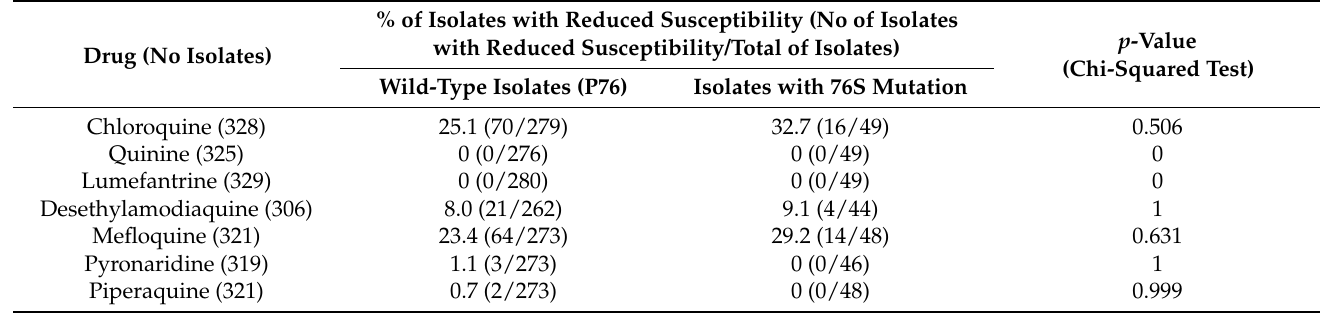
Table 4. Proportions of isolates with in vitro reduced susceptibility to chloroquine, quinine, lumefantrine, desethylamodi- aquine, pyronaridine, and piperaquine according to the pfcoronin genotype (P76 or 76S). % of Isolates with Reduced Susceptibility (No of Isolates with Reduced Susceptibility/Total of Drug (No Isolates)